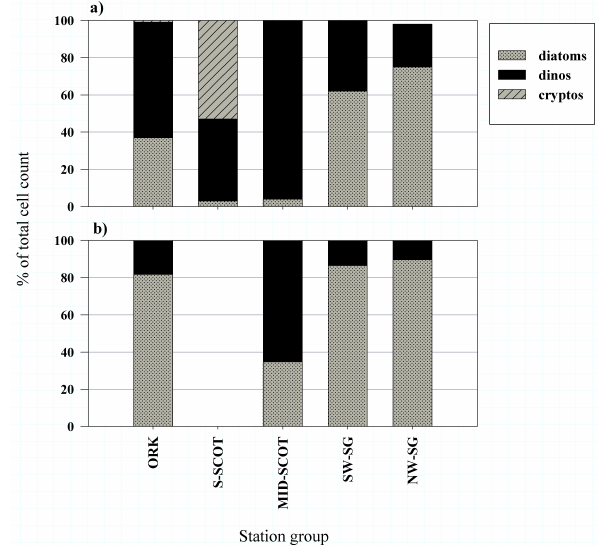
Fig. 3. Microplankton community composition (cell abundance) of the station groups for the (a) 2008 and (b) 2003 cruises. Dinos – dinoflagellates, Cryptos –